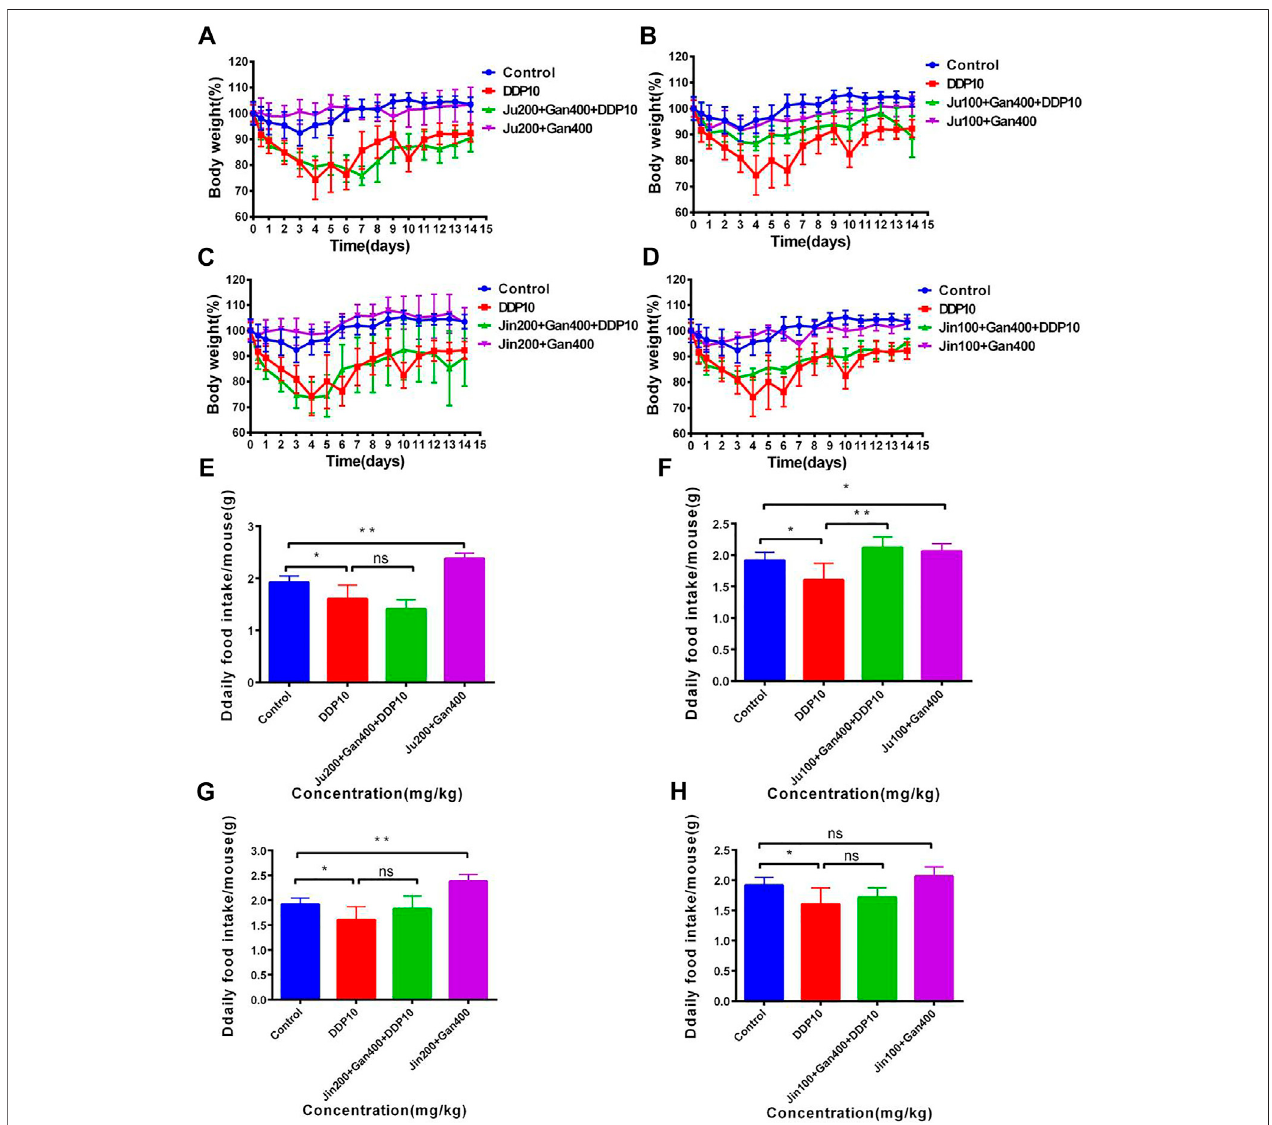
FIGURE 5| The effectof two Chinese medicine formulas on the decrease ofbody weight and food intake ofmice induced by DDP. (A – B) Dose of Ju+ Gan on the decrease of body weight of mice induced by DDP. (C – D) Dose of Jin + Gan on the decrease of body weight of mice induced by DDP. (E – F) Dose of Ju + Gan on the decrease of food intake of mice induced by DDP. (G – H) Dose of Jin + Gan on the decrease of food intake of mice induced by DDP. The mean value ±standard error is shown in the fi gure ( n = 5). The body weight is represented as mean ± SEM. The p values were determined by Student ’ s t test (* p < .05, ** p < .01, *** p < .001).